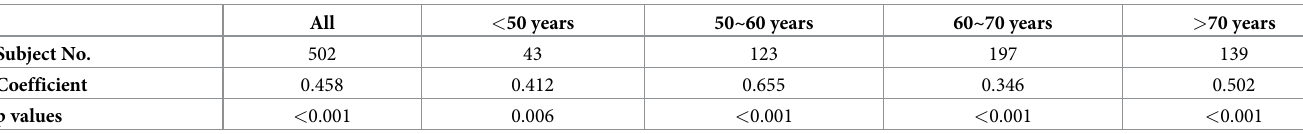
Table 2. Correlation of FIB-4 and TE by